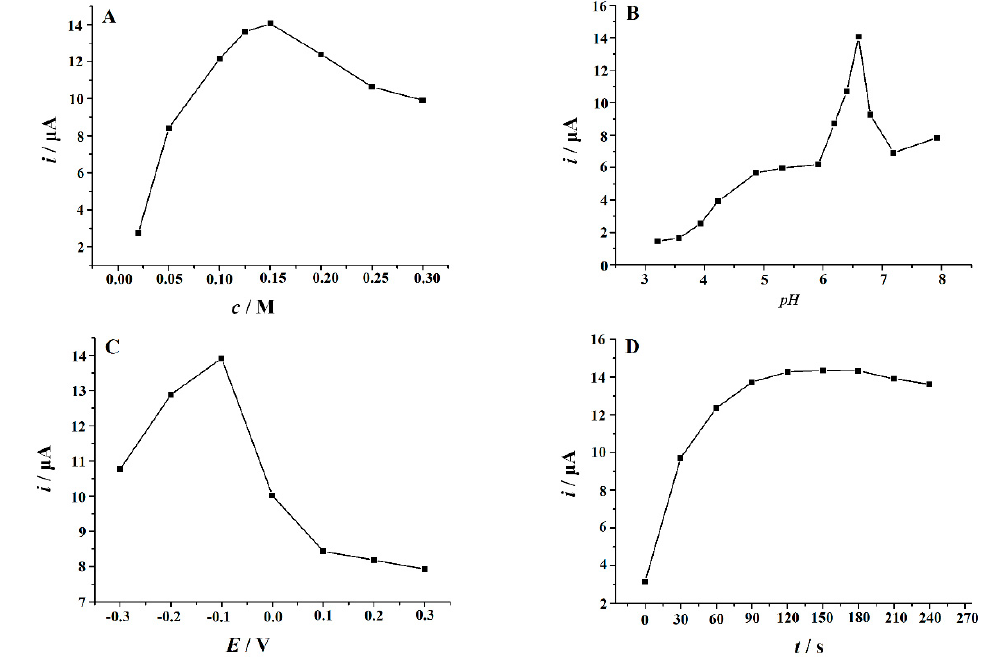
Figure 6. Effects of concentration of an HAc–NaAc buffer ( A ), solution pH ( B ), accumulation potential ( C ), and accumulation time ( D ) on the oxidation peak current of 10 µ M of RhB on the Cu 2 O NPs-ERGO / GCE. When one parameter changed, other parameters were at their optimal values.